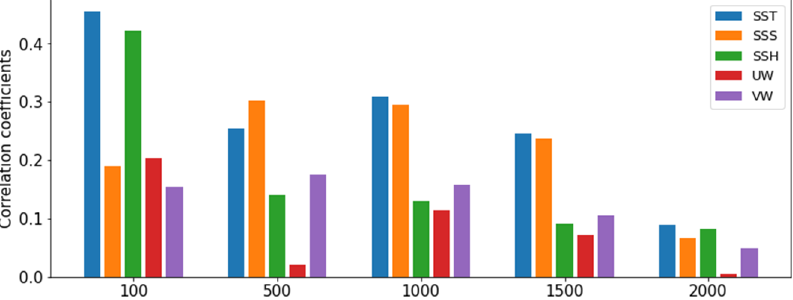
Figure 8. Pearson correlation coefficients between the five sea surface parameters (SST, SSS, SSH, UW, and VW) and the estimated OST with increasing